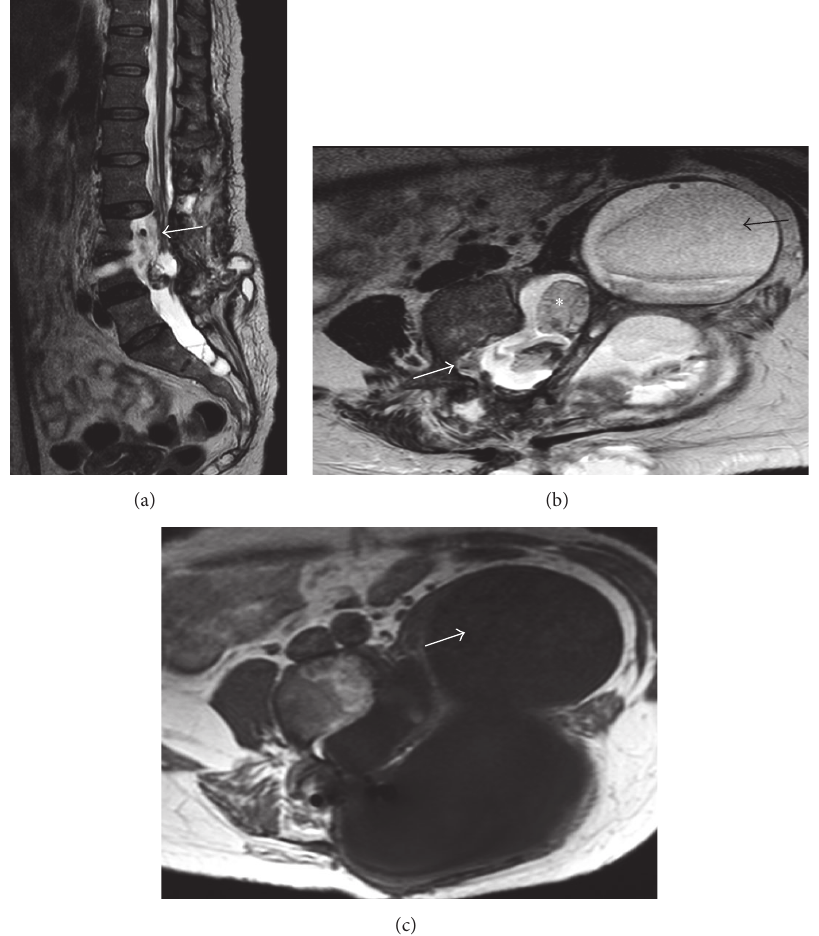
Figure 4: Sagittal and axial T2 weighted (a and b) and axial T1 weighted postgadolinium MRI images at six months after the third operation showed a new giant pseudomeningocele with intra-abdominal extension. The sagittal and axial T2 weighted MRI images (a and b) demonstrated dural sacand cauda rootscompression (white arrows)and theinhomogeneous non-CSFlikecontent of thepseudomeningocele (black arrow) probably due to the presence of surgical patch materials and blood products. Axial T1 weighted after gadolinium MRI picture (c) excluded pathological enhancement (white